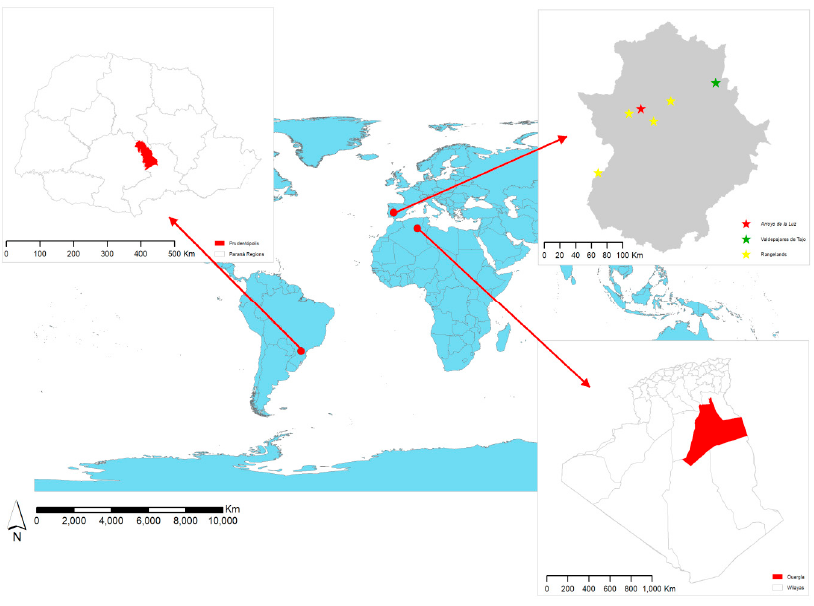
Figure 1. Geographical location of the study cases.